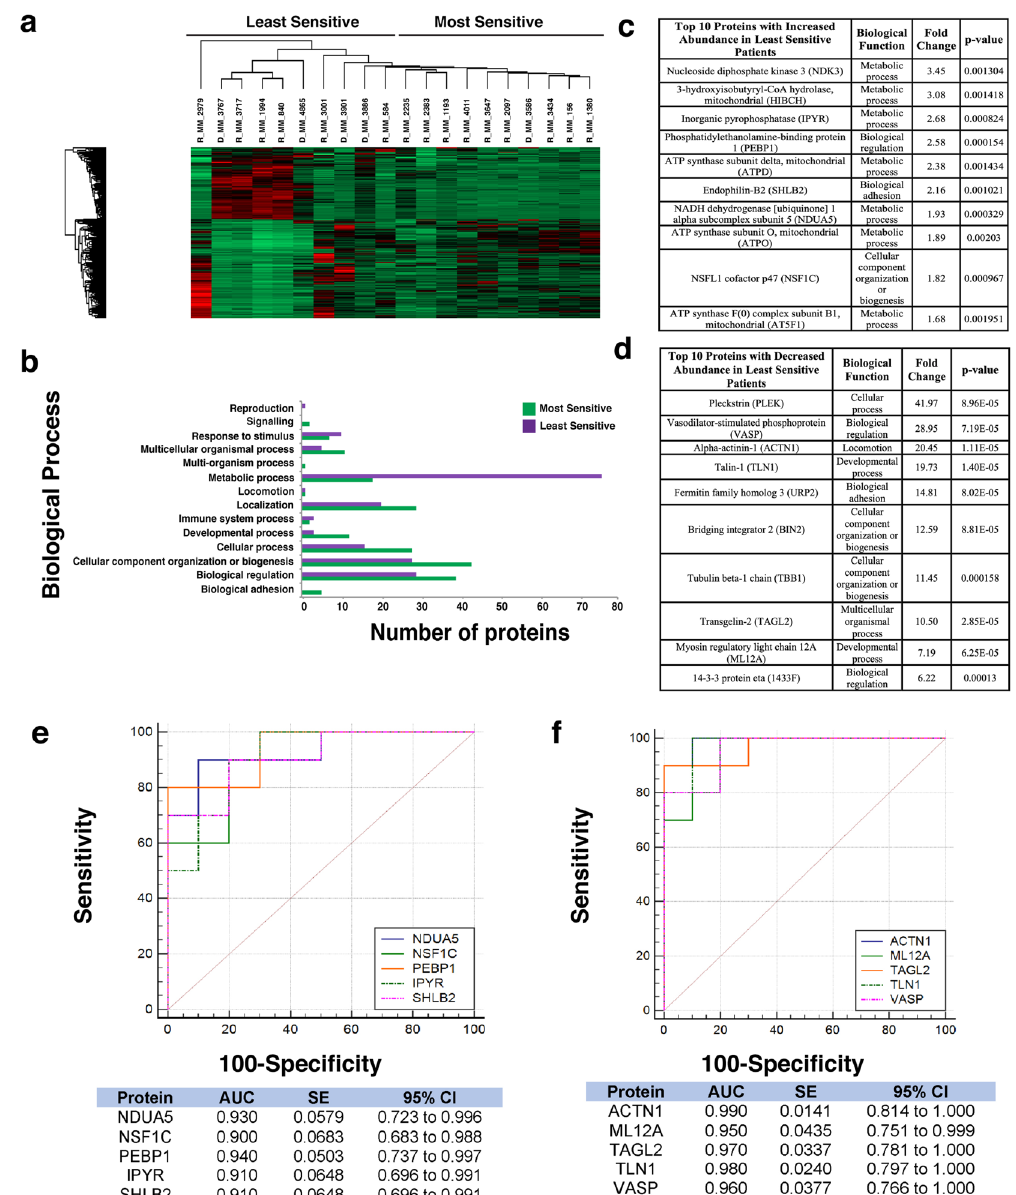
Figure 6. Proteomic analysis of patients following Navitoclax treatment. ( a ) Heatmap showing protein abundance changes of patients most and least sensitive to navitoclax. Red indicates an increase in protein abundance, while green a decrease in protein abundance. ( b ) Graph showing the biological processes associated with the most and least sensitive patients. ( c ) List of the top ten proteins with increased abundance in the least sensitive patients. The associated biological function, fold change and p-value are also shown. Proteins were designated by p-value and arranged hierarchically by fold change. ( d ) List of the top ten proteins with decreased abundance in the least sensitive patients. The associated biological function, fold change and p-value are also shown. Proteins were designated by p-value and arranged hierarchically by fold change. ( e ) ROC analysis for the top five statistically significant proteins with an increased abundance for the least sensitive patients to Navitoclax, including the calculated AUC, standard error (SE) and 95% confidence interval (CI). ( f ) ROC analysis for the top five statistically significant proteins with a decreased abundance for the least sensitive patients to Navitoclax, including the calculated AUC, standard error (SE) and 95% confidence interval